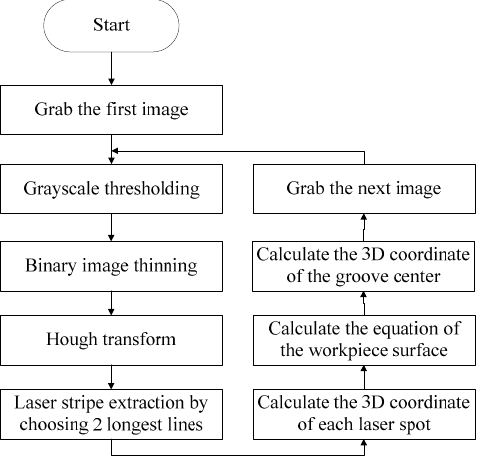
Figure 14. The image processing algorithm when laser light source is on.